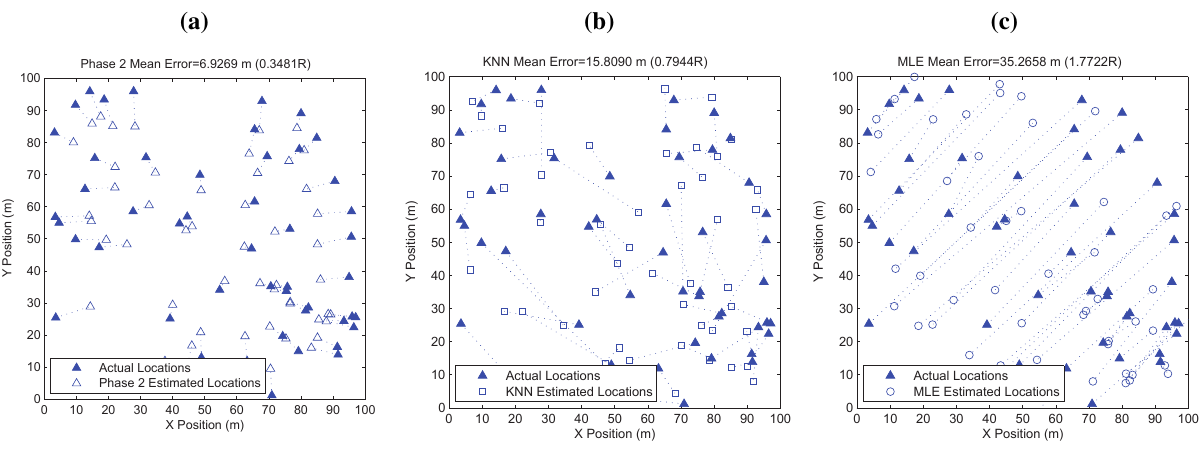
Figure 9. Location estimation produced by our algorithm versus KNN and MLE. (a) our estimated locations; (b) KNN estimated locations; (c) MLE estimated locations.